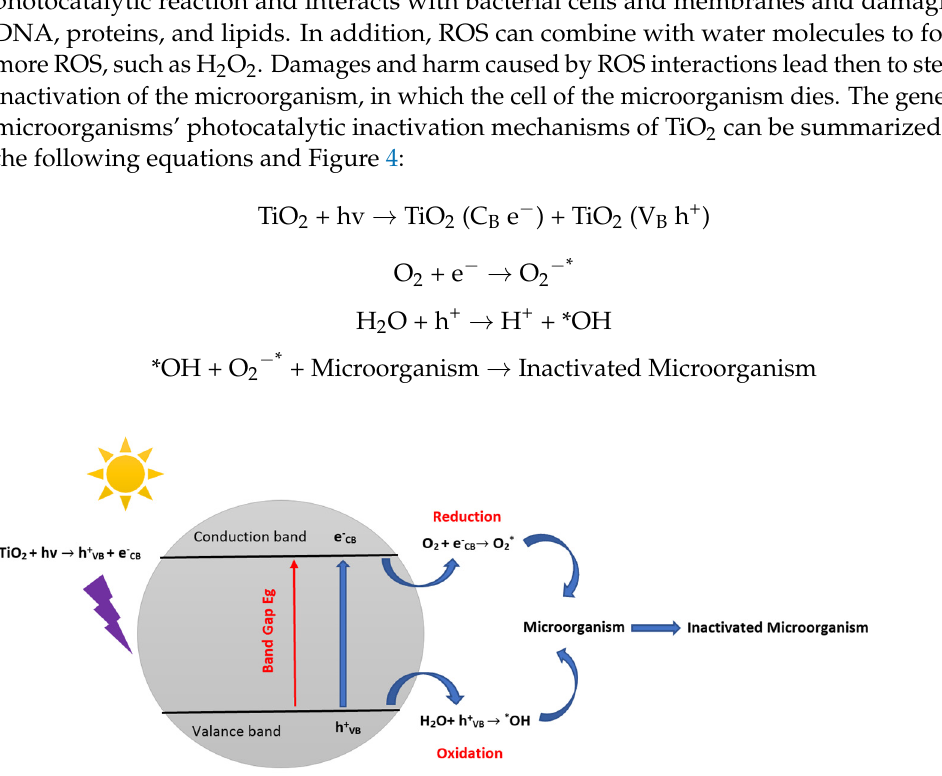
Figure 4. Schematic illustration of the antibacterial photocatalytic mechanisms of TiO 2 (inspired from ref [89]).